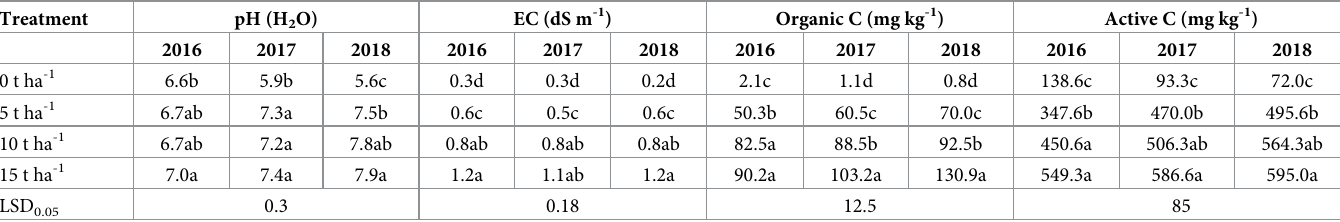
Values followed by the same letter in a column are not significantly (P < 0.05) different.